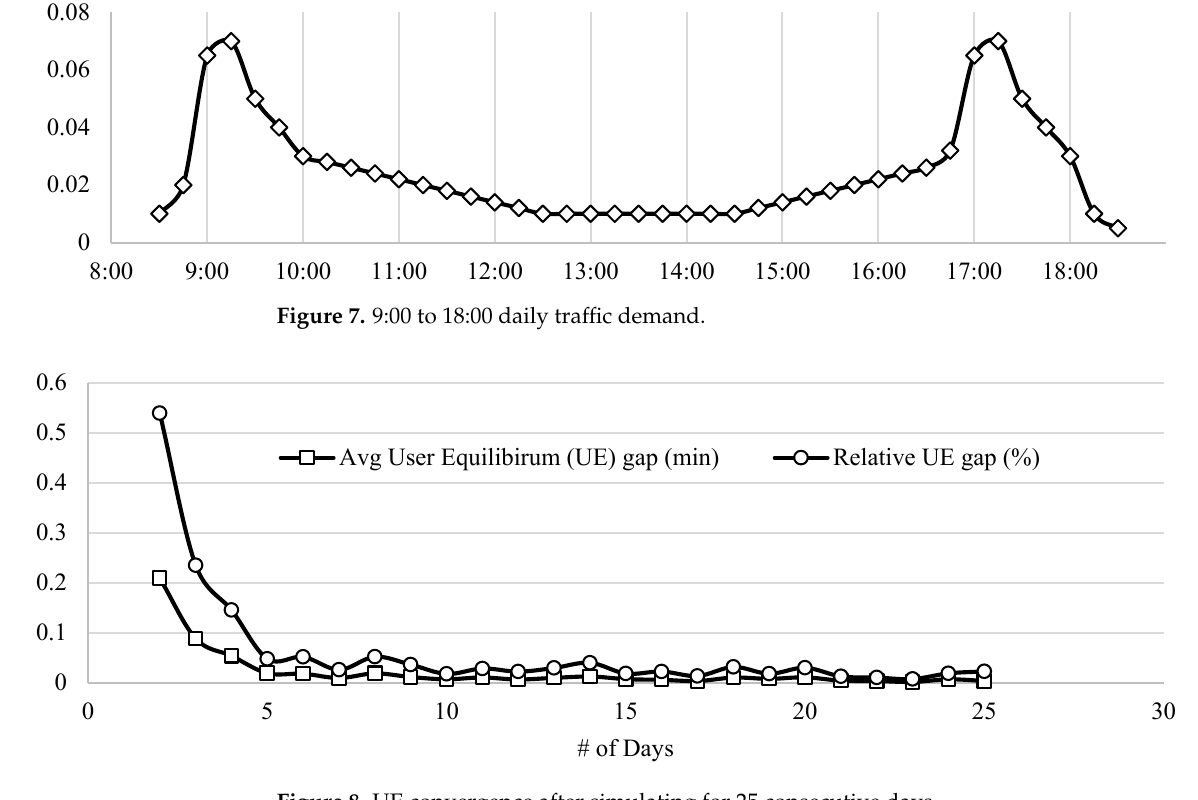
Figure 8. UE convergence after simulating for 25 consecutive days.